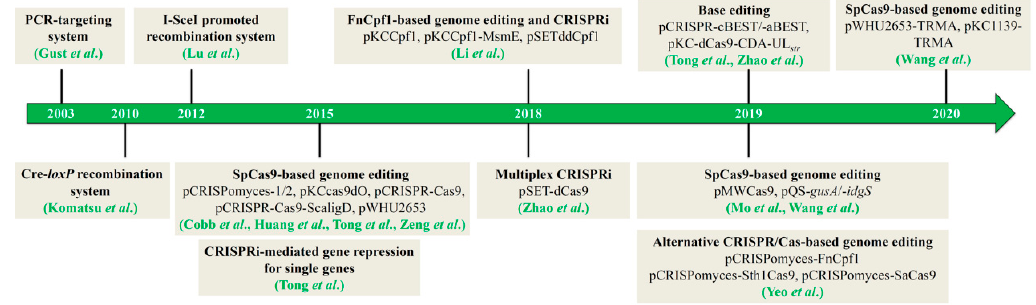
Figure 1. The development course of genome editing technologies in Streptomyces .